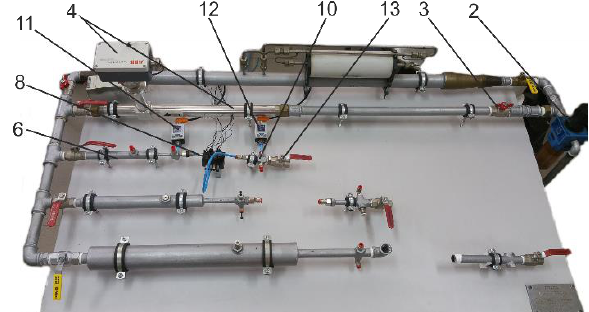
Fig. 10. Characteristic q